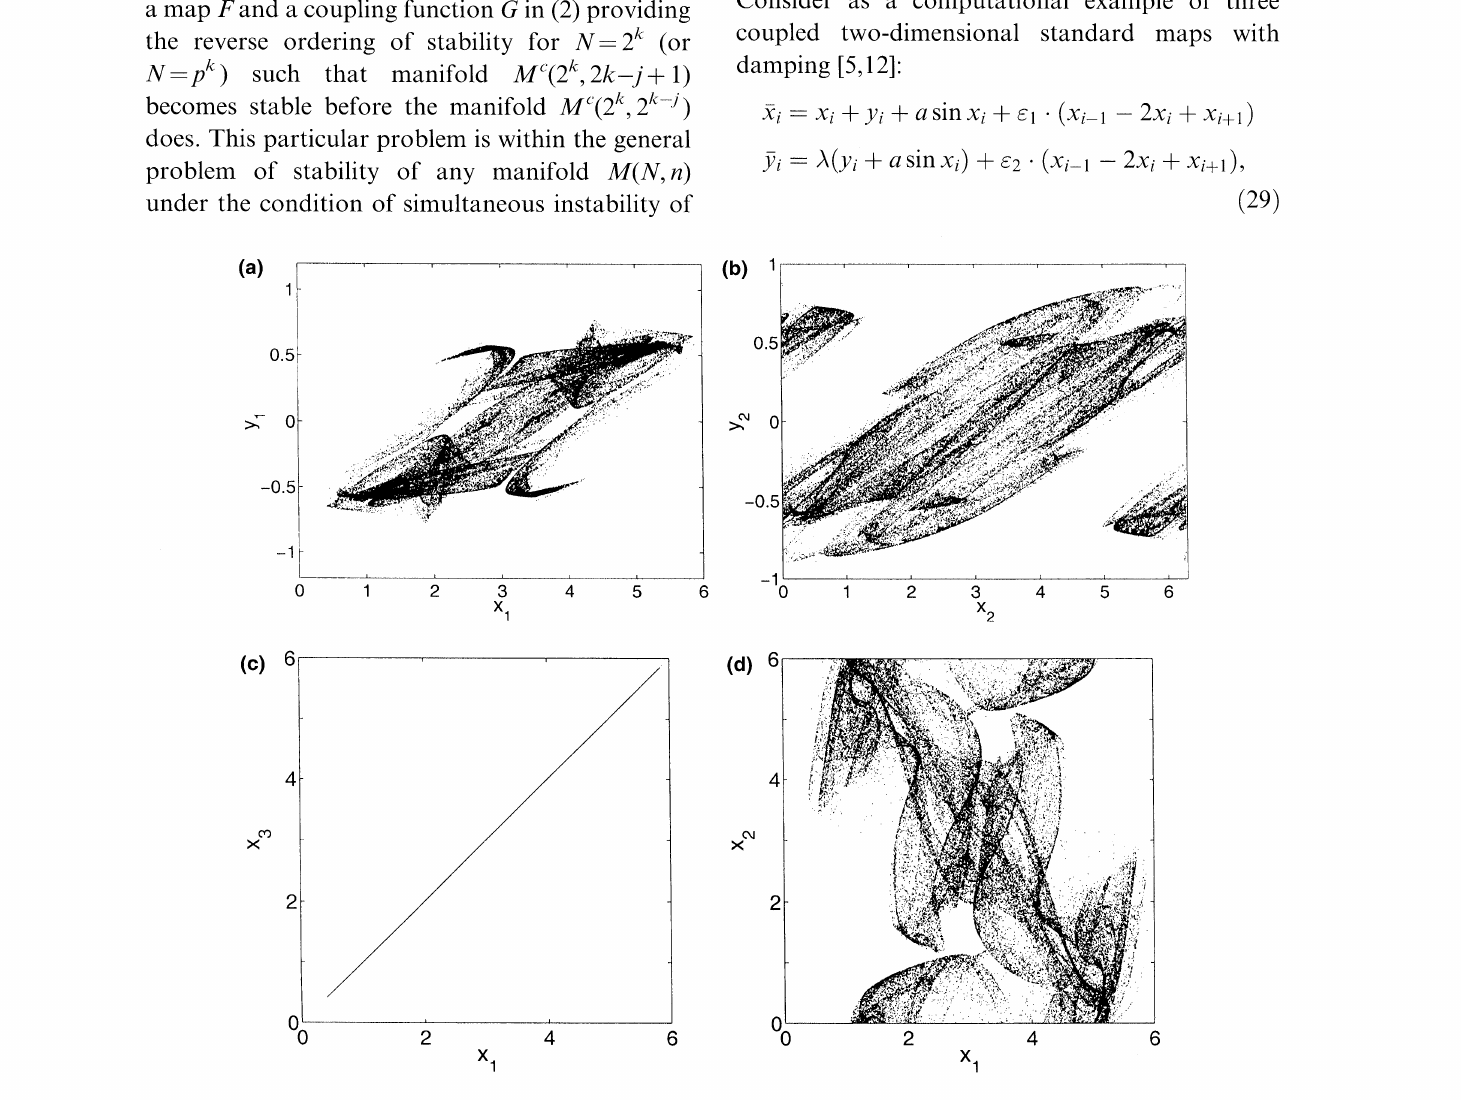
FIGURE Chaotic cluster synchronization of three coupled damped standard maps. Case cl #0, C2---0. (a) Lying in the stable manifold M(3, 2) we observe the chaotic attractor in a projection onto (xl, Yl). (b) Chaotic attractor in the projection of variables of the middle element (xz, y2). (c) Stable manifold M(3,2) defining the synchronization between the first and the last element of the array. (d) Out of synchronization between the first (the last) and the middle